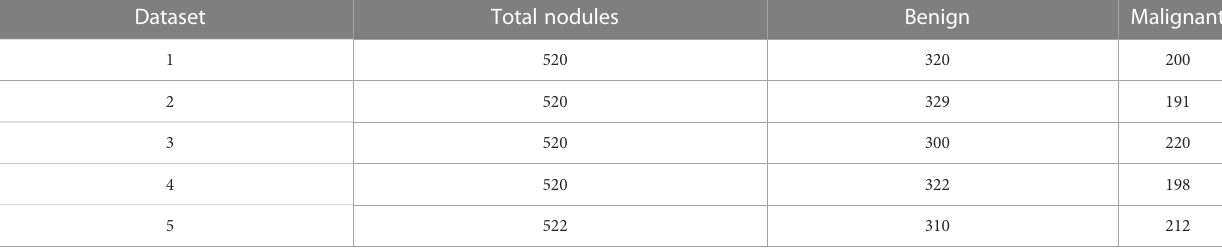
TABLE 1 The subdivided datasets for subsequent nodular region comparison